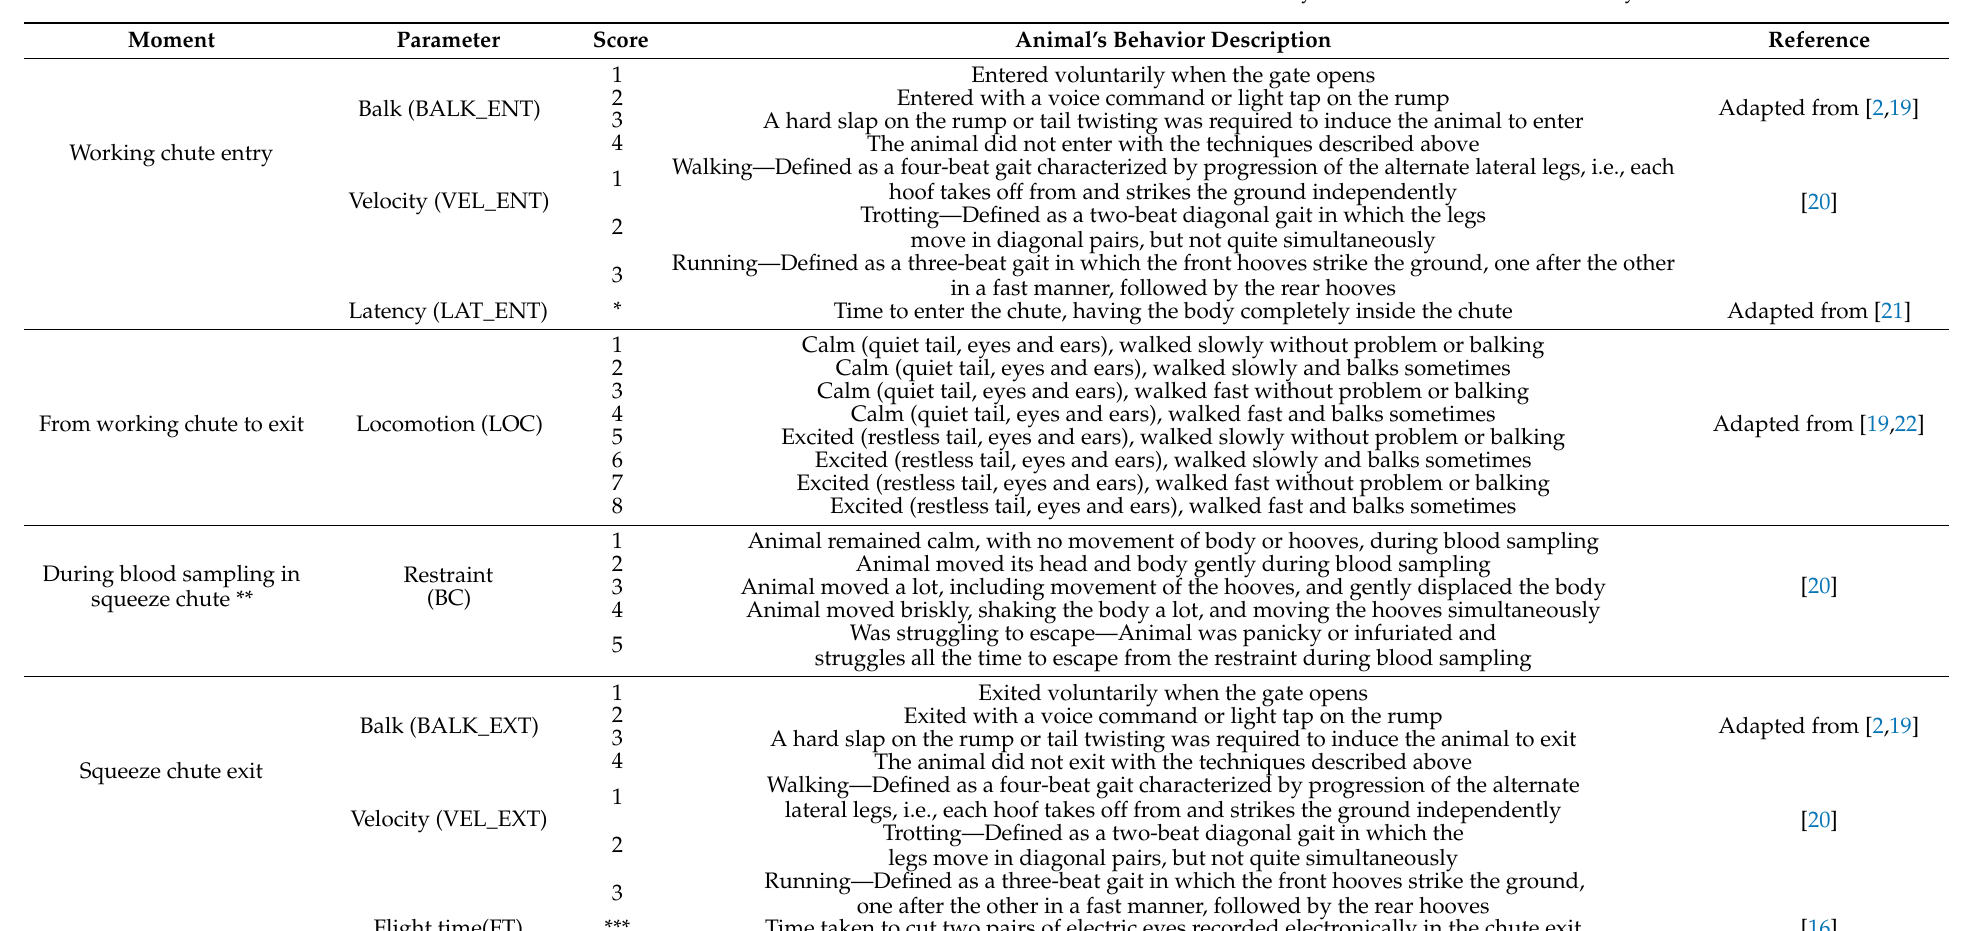
Table 1. Animal’s behavioral measurements from the chute entrance to chute exit measured on days − 21 and 14 in the chute